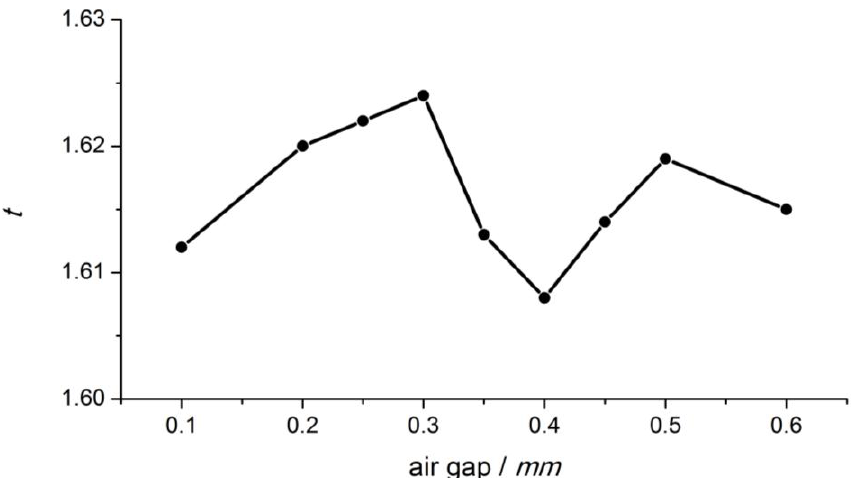
Figure 27. Influence of air gap on the torque ripple